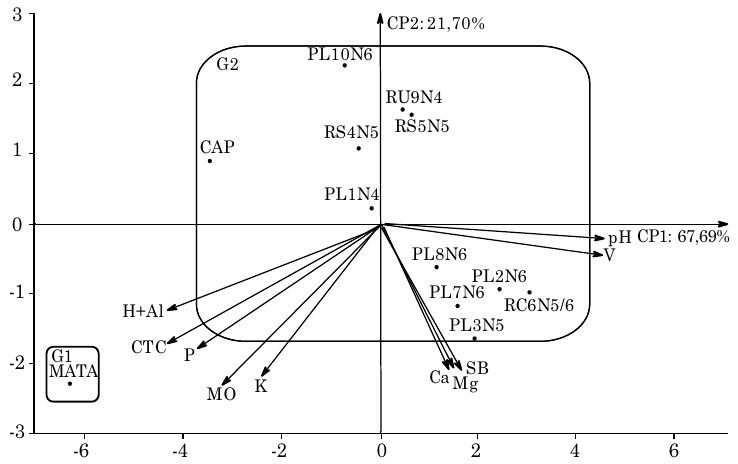
Figura 4. Gráfico biplot construído com os dois primeiros componentes principais, evidenciando a distribuição dos atributos químicos avaliados nas